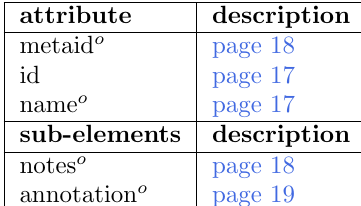
Level 1 Version 2 XML Schema.